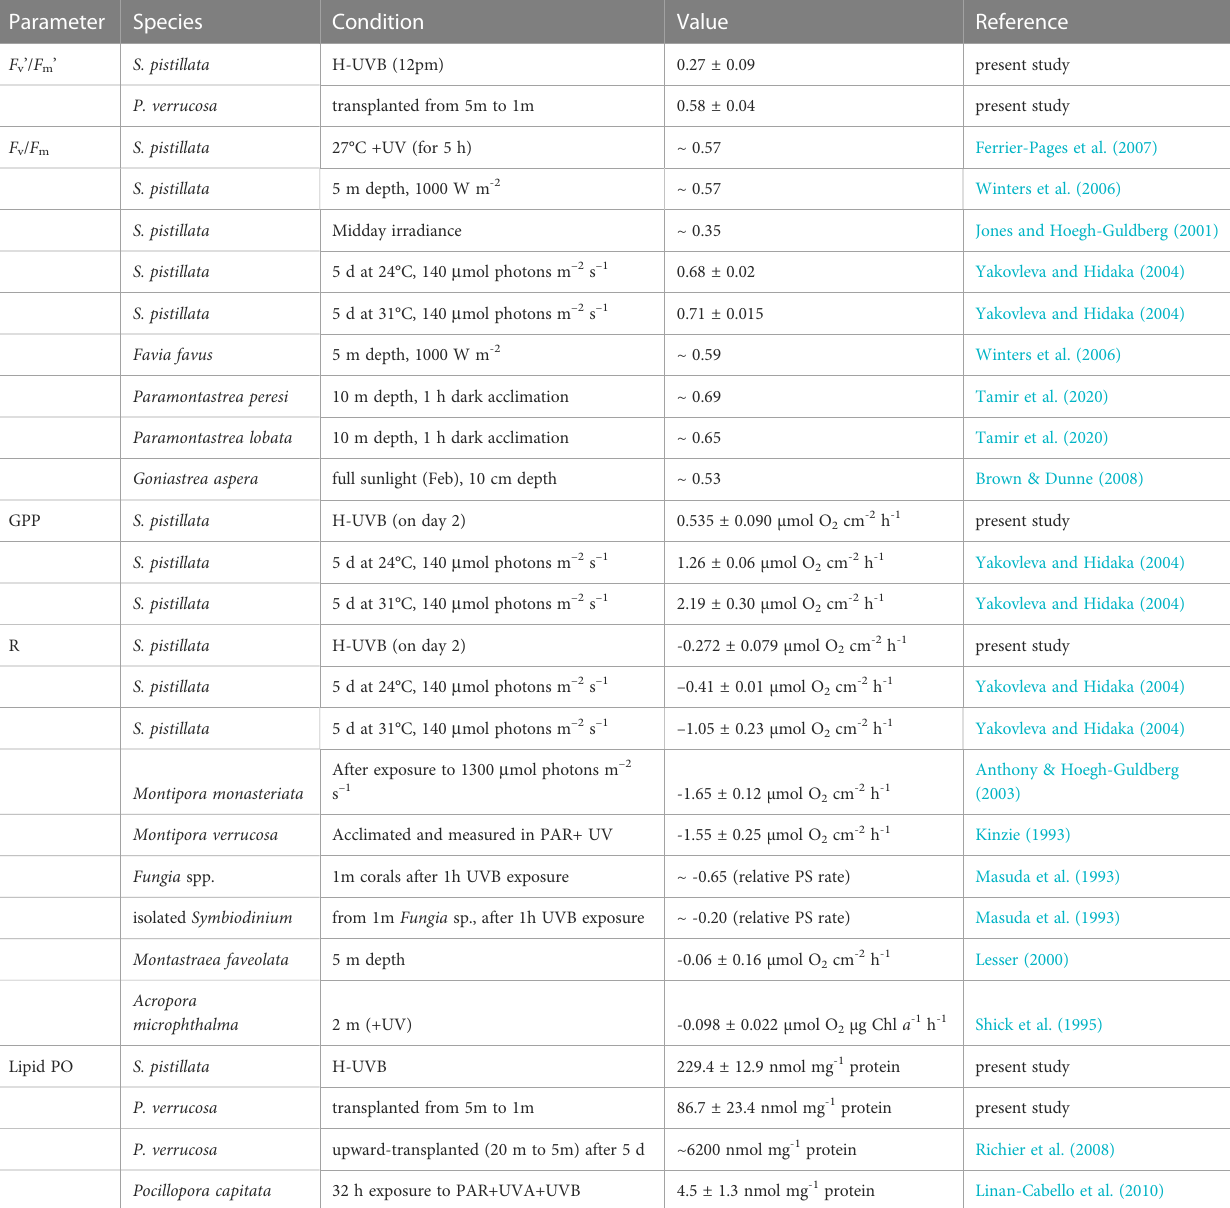
TABLE 3 Physiological parameters of Stylophora pistillata and Pocillopora verrucosa measured in the present study in comparison to previously reported values from the same species as well as other coral